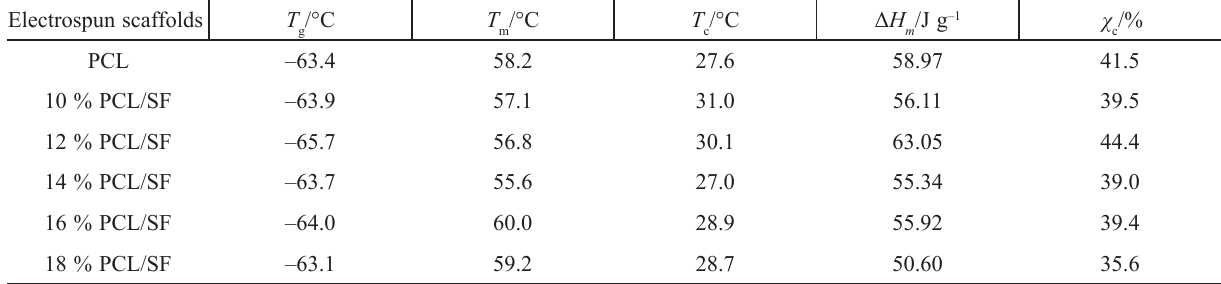
Table 2 – Transition temperatures and degree of crystallinity of the electrospun scaffolds Electrospun